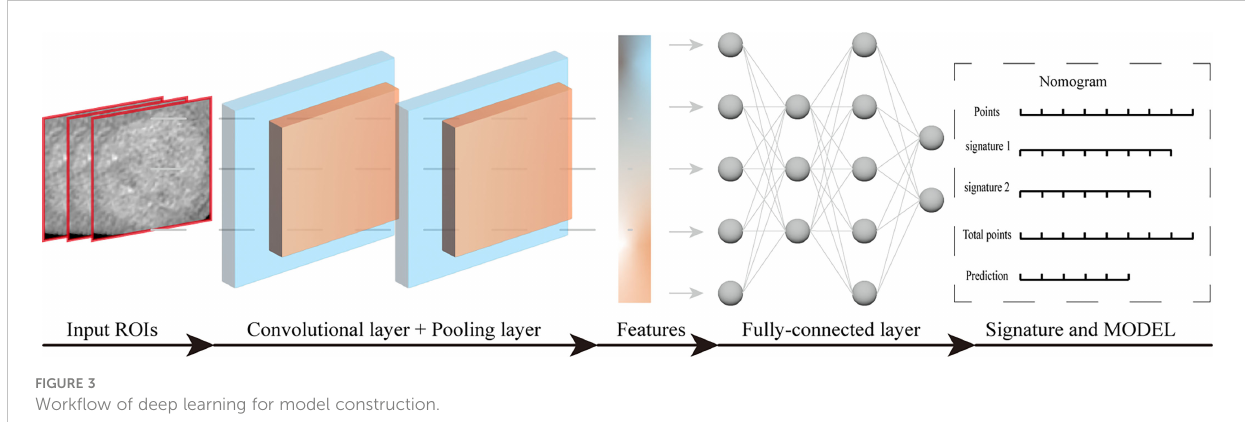
FIGURE 3 Work fl ow of deep learning for model